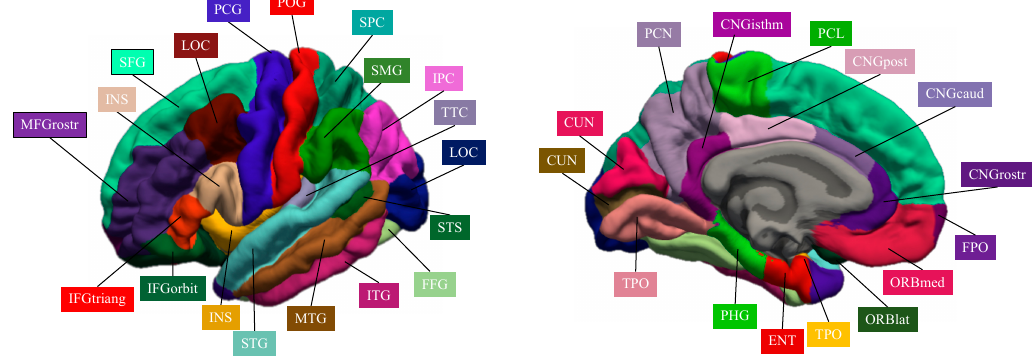
Figure 1. Cortical brain regions obtained by Freesurer parcellation.